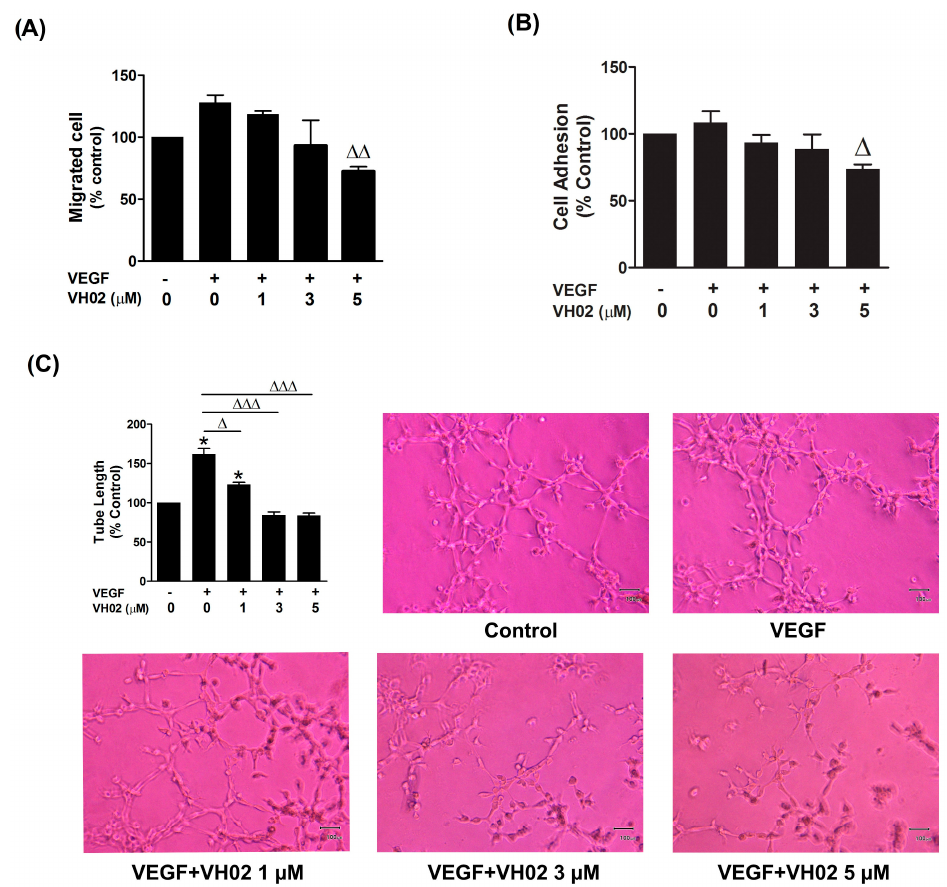
Figure 2. Influence of VH02 on VEGF-induced endothelial cell migration, cell adhesion and tube formation. ( A ) VH02 inhibited VEGF-induced EA.hy 926 migration. EA.hy 926 were allowed